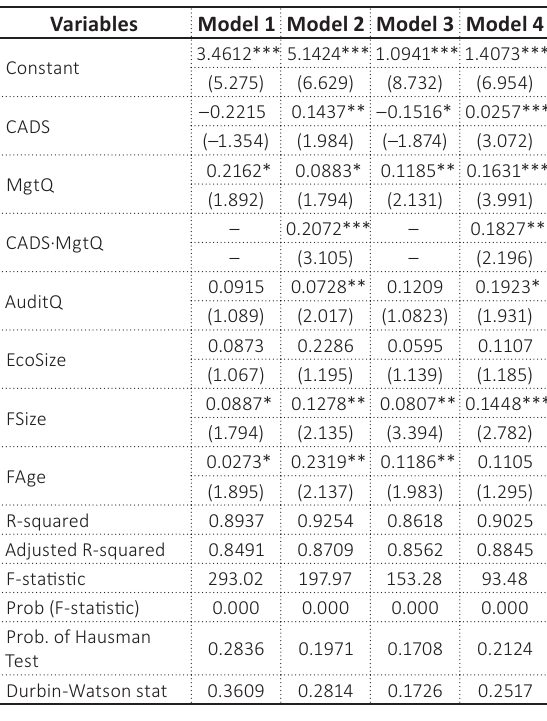
Table 3. Regression results